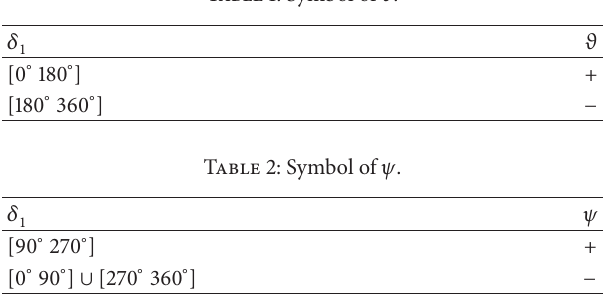
Figure 3: Geometrical relationship of Euler attitude and cone attitude. Table 1: Symbol of 𝜗 .